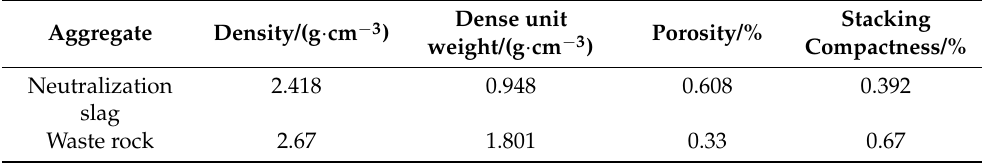
Table 1. Physical parameters of neutralization slag.